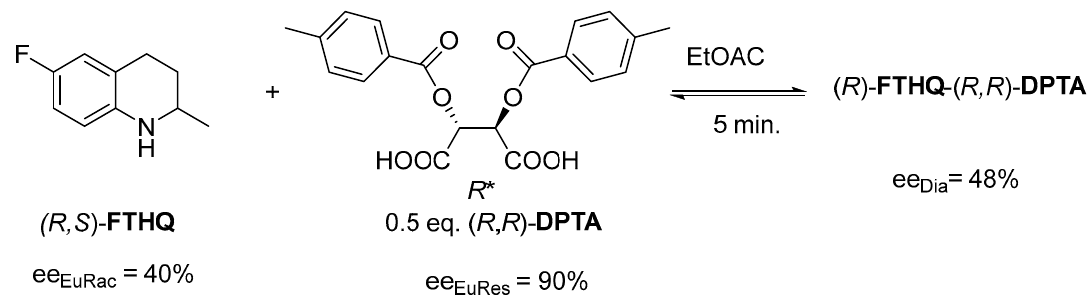
Figure 6. Diastereomeric salt formation of ( R , S ) ‐ FTHQ with half equivalent ( R , R ) ‐ DPTA.